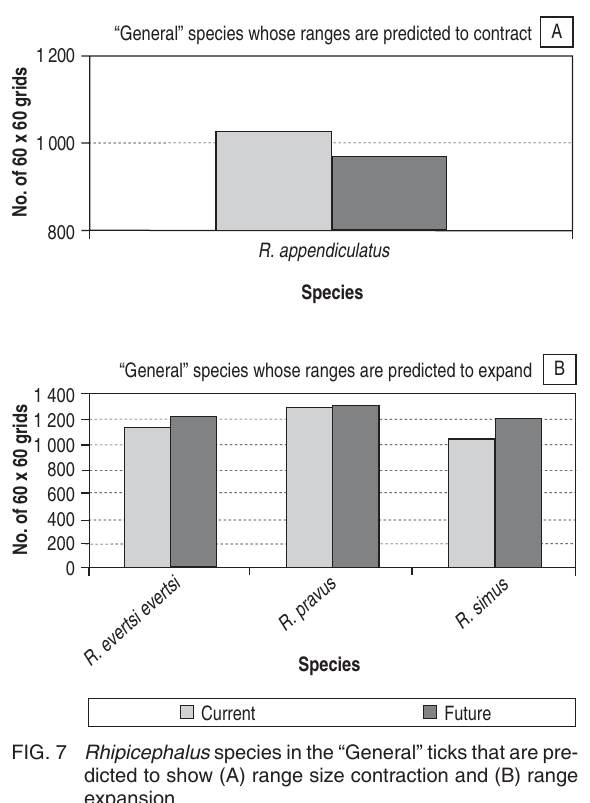
FIG. 7 Rhipicephalus species in the “General” ticks that are pre- dicted to show (A) range size contraction and (B) range expansion FIG. 8 Species richness pattern of Rhipicephalus species in sub-